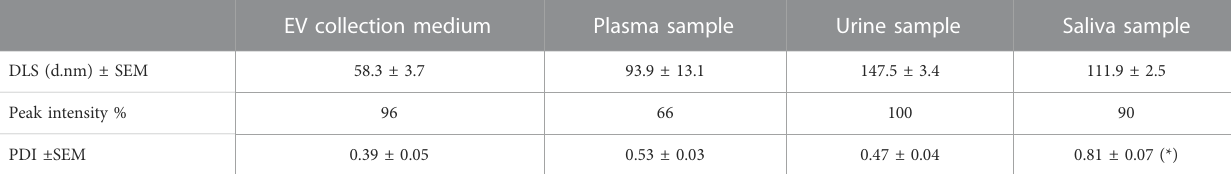
TABLE 1 Physicochemical characterization of small